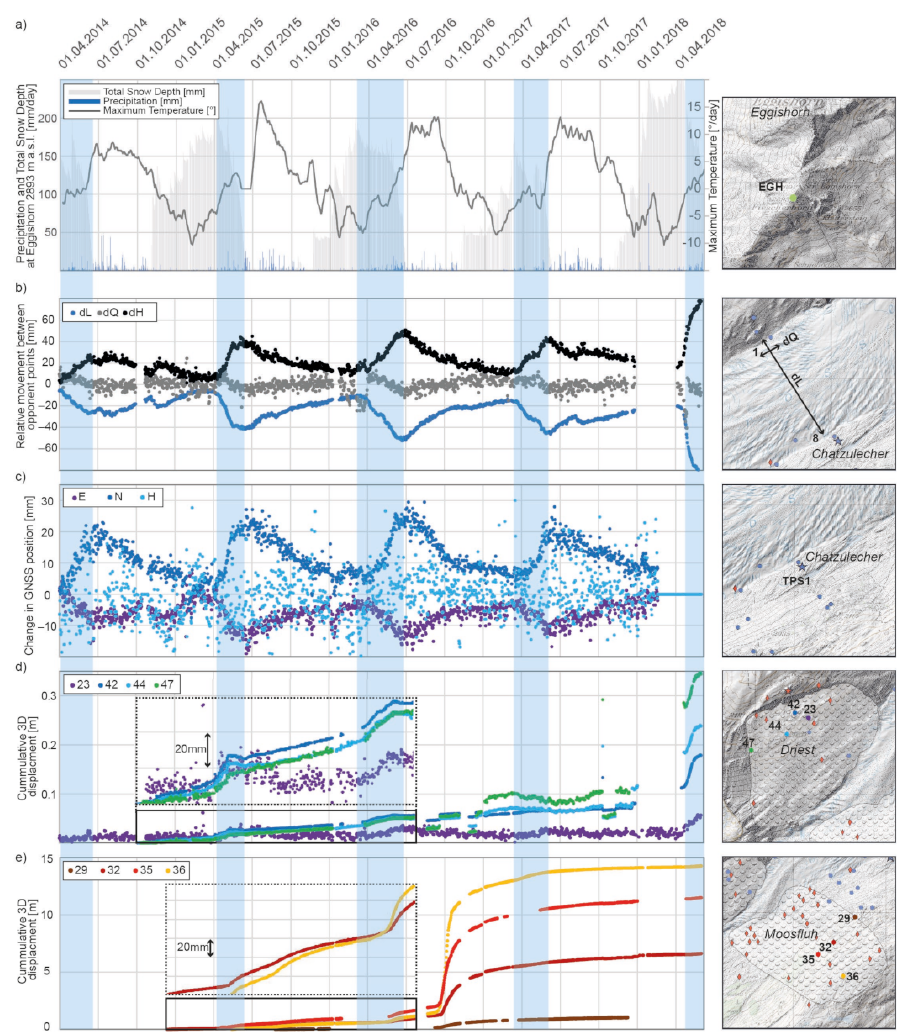
Figure 9. Four-year time series of meteo, total station monitoring, and GNSS data at the Great Aletsch Glacier region and location of the measurement points. Blue bars represent the time period of snow melt. ( a ) Total snow depth, precipitation, and maximum temperatures recorded at Eggishorn (2893 m a.s.l.); ( b ) relative movements in longitudinal, height, and orthogonal direction of the line between two reflector points (1 and 8) across the Great Aletsch Glacier showing a reversible strain of about 6 × 10 − 5 with an irreversible component of about 7 × 10 − 6 ; ( c ) change of a single GNSS sensor position recorded at Chatzulecher (TPS1) located in ‘stable’ ground, evidencing the existence of reversible slope deformations in the range of ± 12 mm for the East and ± 20 mm for the North component; ( d ) cumulative 3D displacement of reflectors located within the active Driest instability north of the Aletsch Glacier; ( e ) cumulative 3D displacement of reflectors located within the Moosfluh instability showing an acceleration of the landslide movement during snowmelt in April/May of every year and the exceptional event of September